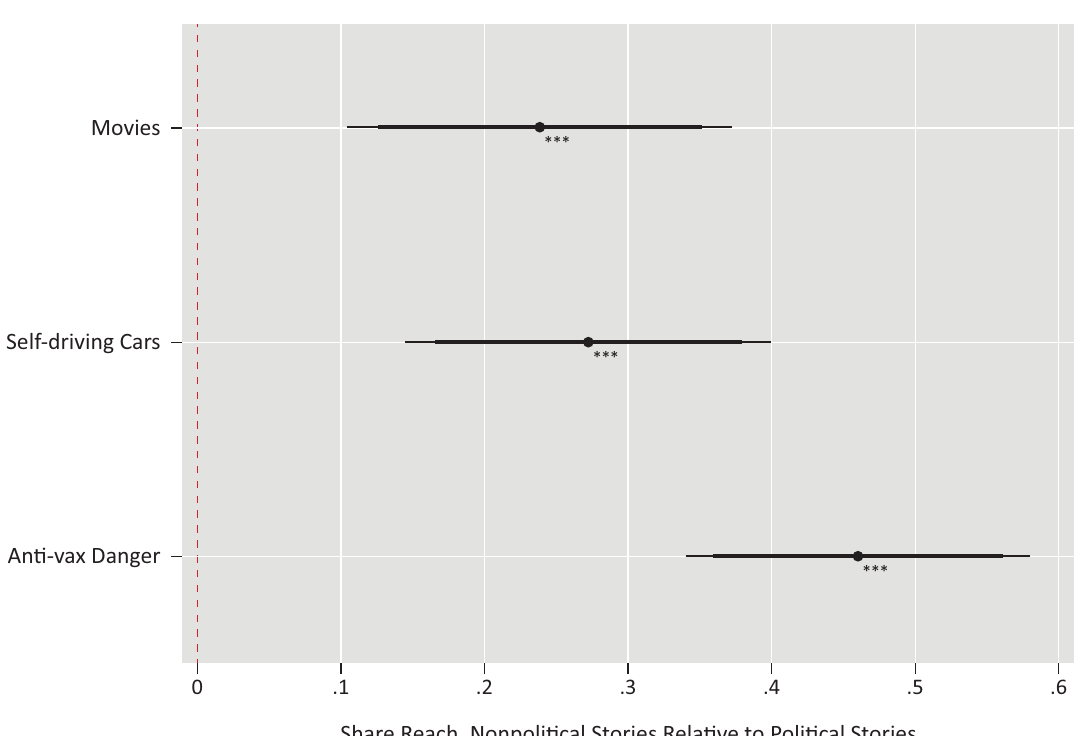
Figure 2. Share reach of non-political stories relative to political stories. Notes: share reach measured as “How many people would you share this news with?” (4 pt., 0 = “none”, 3 = “a lot.”). N = 1,872.